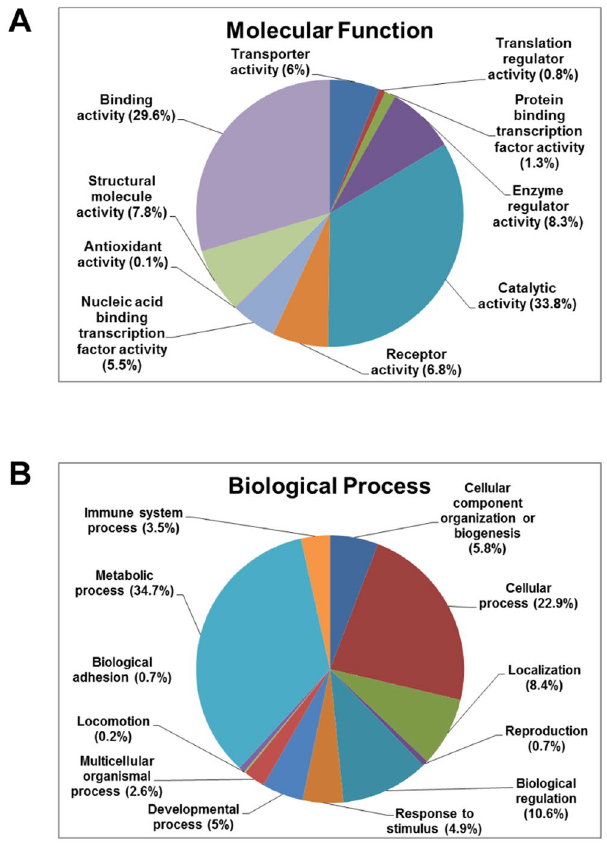
Figure 3. Functional categorization of the proteins that are up-regulated or down-regulated in ganetespib- treated bladder cancer cells. Differentially regulated proteins were analyzed for “functional categories” using the UnitProt knowledge database and the PANTHER classification system. Pie charts display the distribution of ≥ 2-fold up-regulated proteins detected in the ganetespib-treated 5637 cells based on molecular function ( A ) and ≥ 2-fold down-regulated proteins detected in the ganetespib-treated 5637 cells based on biological process ( B ). The percentages of the identified and quantified proteins in each category are indicated in